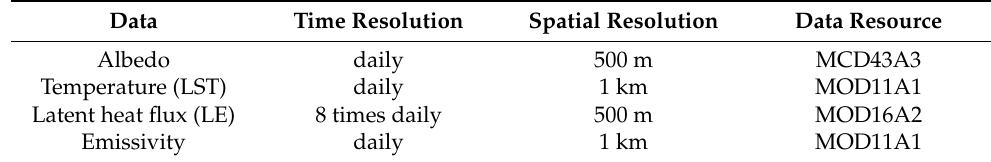
Table 1. Moderate Resolution Imaging Spectroradiometer (MODIS) data items and descriptions.